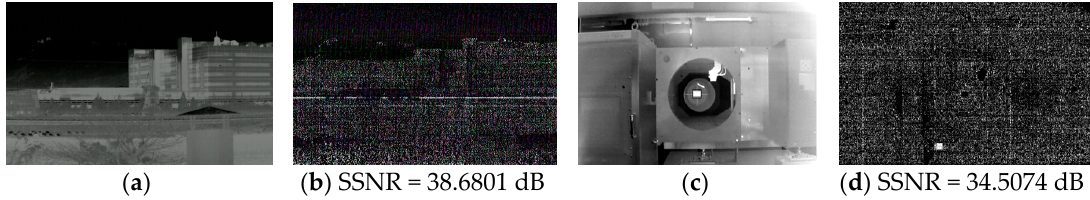
Figure 5. An example of evaluating the noise in MWIR images using subtraction signal-to-noise ratio